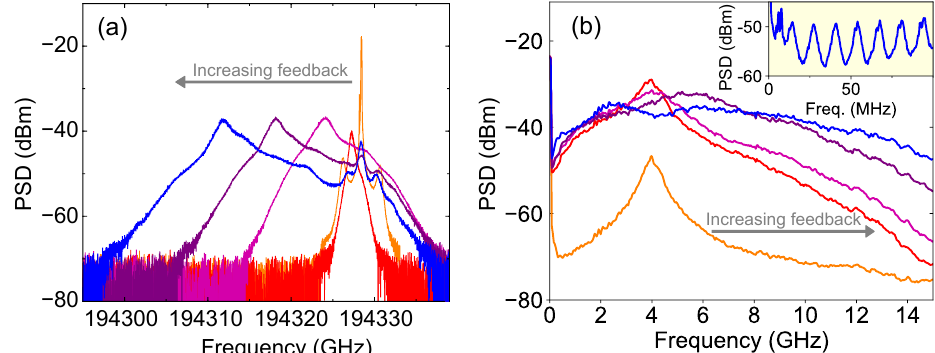
Figure 3. Experimental signatures of delayed optical feedback on the optical and radio-frequency (RF) spectra of a semiconductor laser. ( a ) High-resolution optical spectra of the laser without feedback (orange) and with different amounts of feedback. ( b ) Effect of delayed optical feedback on the RF power spectral density. The RF spectrum is depicted over a 15 GHz frequency span for increasing feedback conditions. RF spectra are shown for the solitary laser emission (orange line) and four successively higher values of the feedback rate (from red towards blue). Inset: Zoom of the first 100 MHz for the maximum feedback rate. The external cavity frequency resonances are here clearly visible as equidistant peaks separated by 13.29 MHz. The arrow indicates the broadening direction of the optical spectrum and the overall bandwidth increase of the RF spectrum when the feedback rate increases,